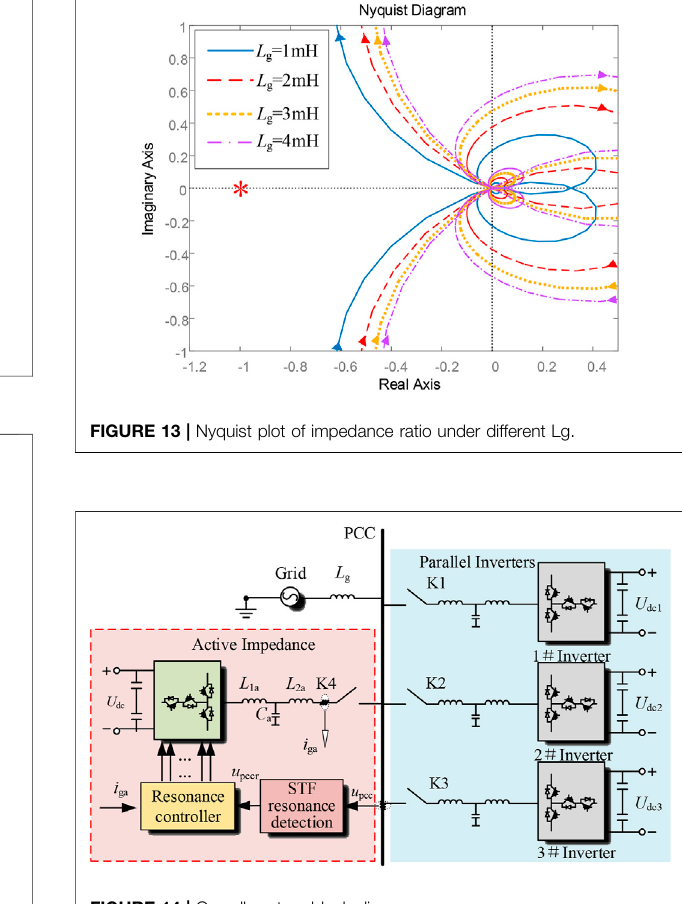
FIGURE 12 | Bode diagram of system impedance with active impedance.